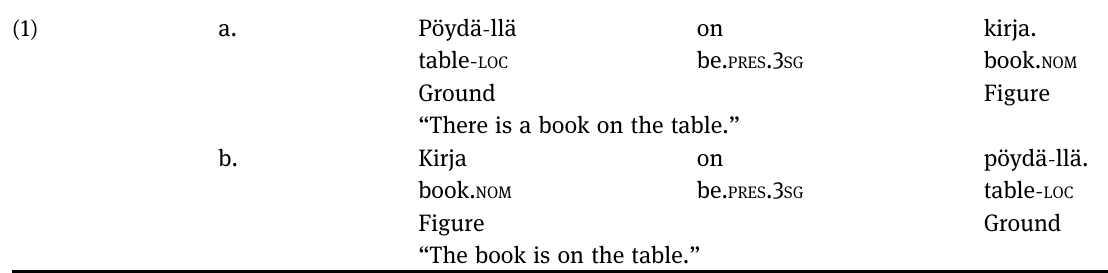
Table 1: Figure – Ground reversals in existential and locative sentences found by Clark ( 1978 ) and Freeze ( 1992 )